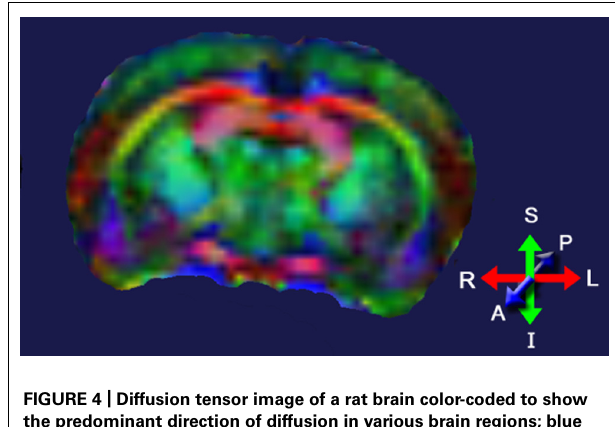
FIGURE 4 | Diffusion tensor image of a rat brain color-coded to show the predominant direction of diffusion in various brain regions; blue indicates diffusion between anterior (A) and posterior (P), red indicates flow between left (L) and right (R), and green indicates flow between superior (S) and inferior (I). Adapted from Robbins etal.